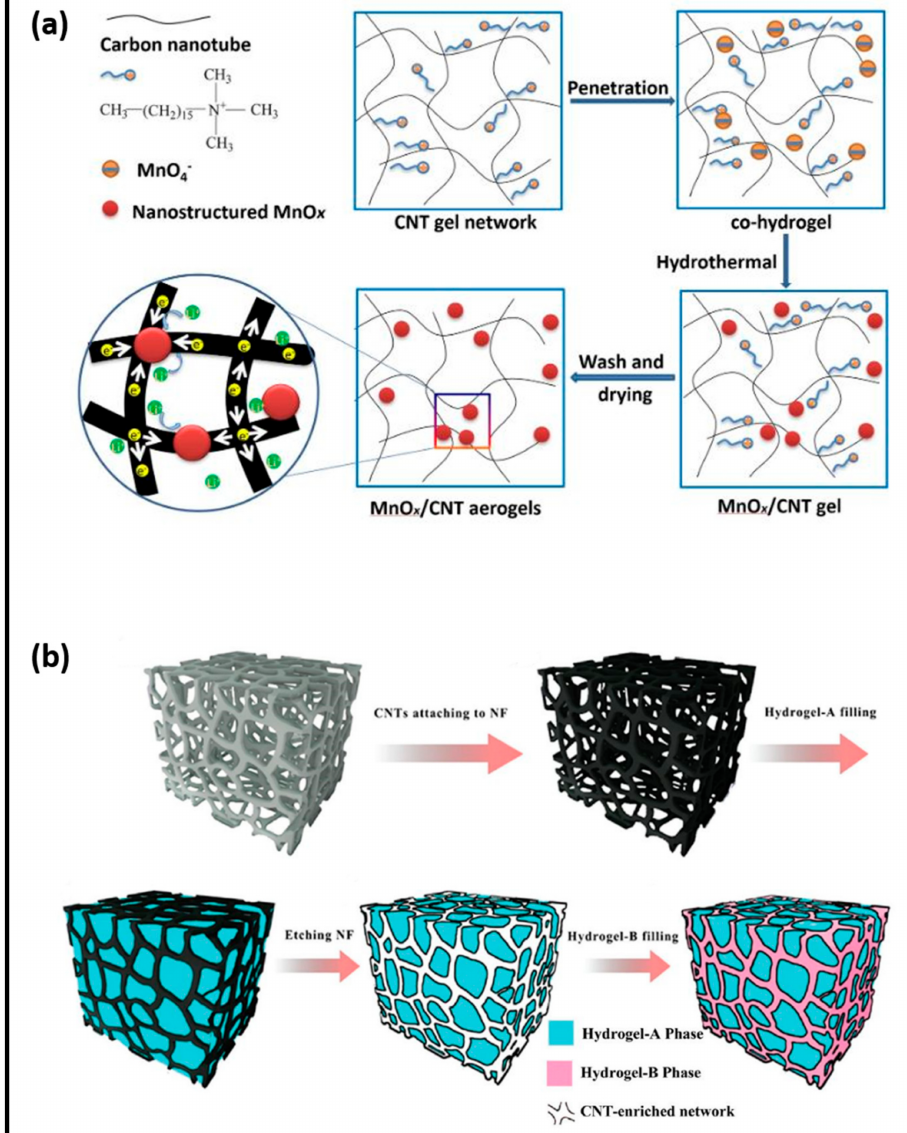
Figure 3. Scheme showing the synthesis of CNT-based hydrogels: ( a ) MnO x /CNT aerogels [74], ( b ) general process of the double network hydrogel